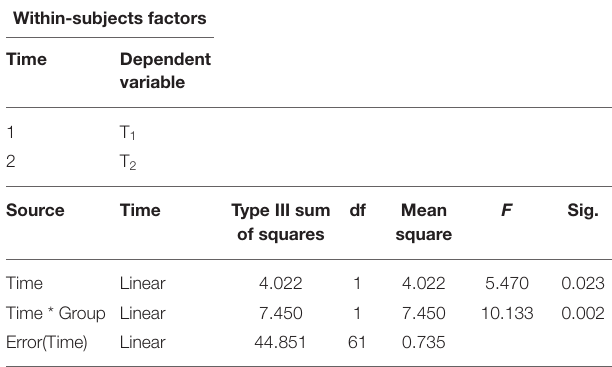
TABLE 4A | Tests of within-subjects contrasts.